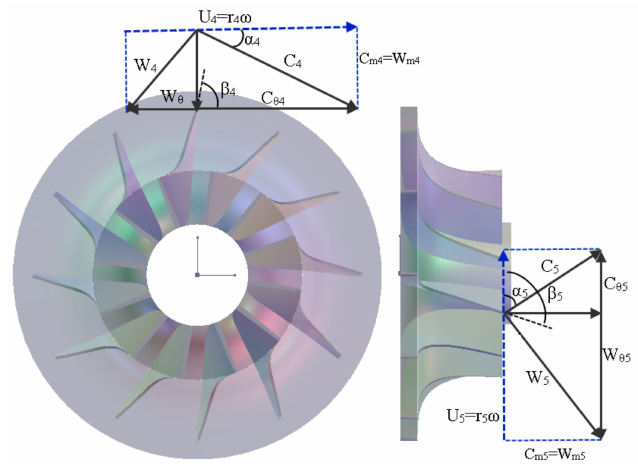
Figure 3. Velocity diagram in a rotor